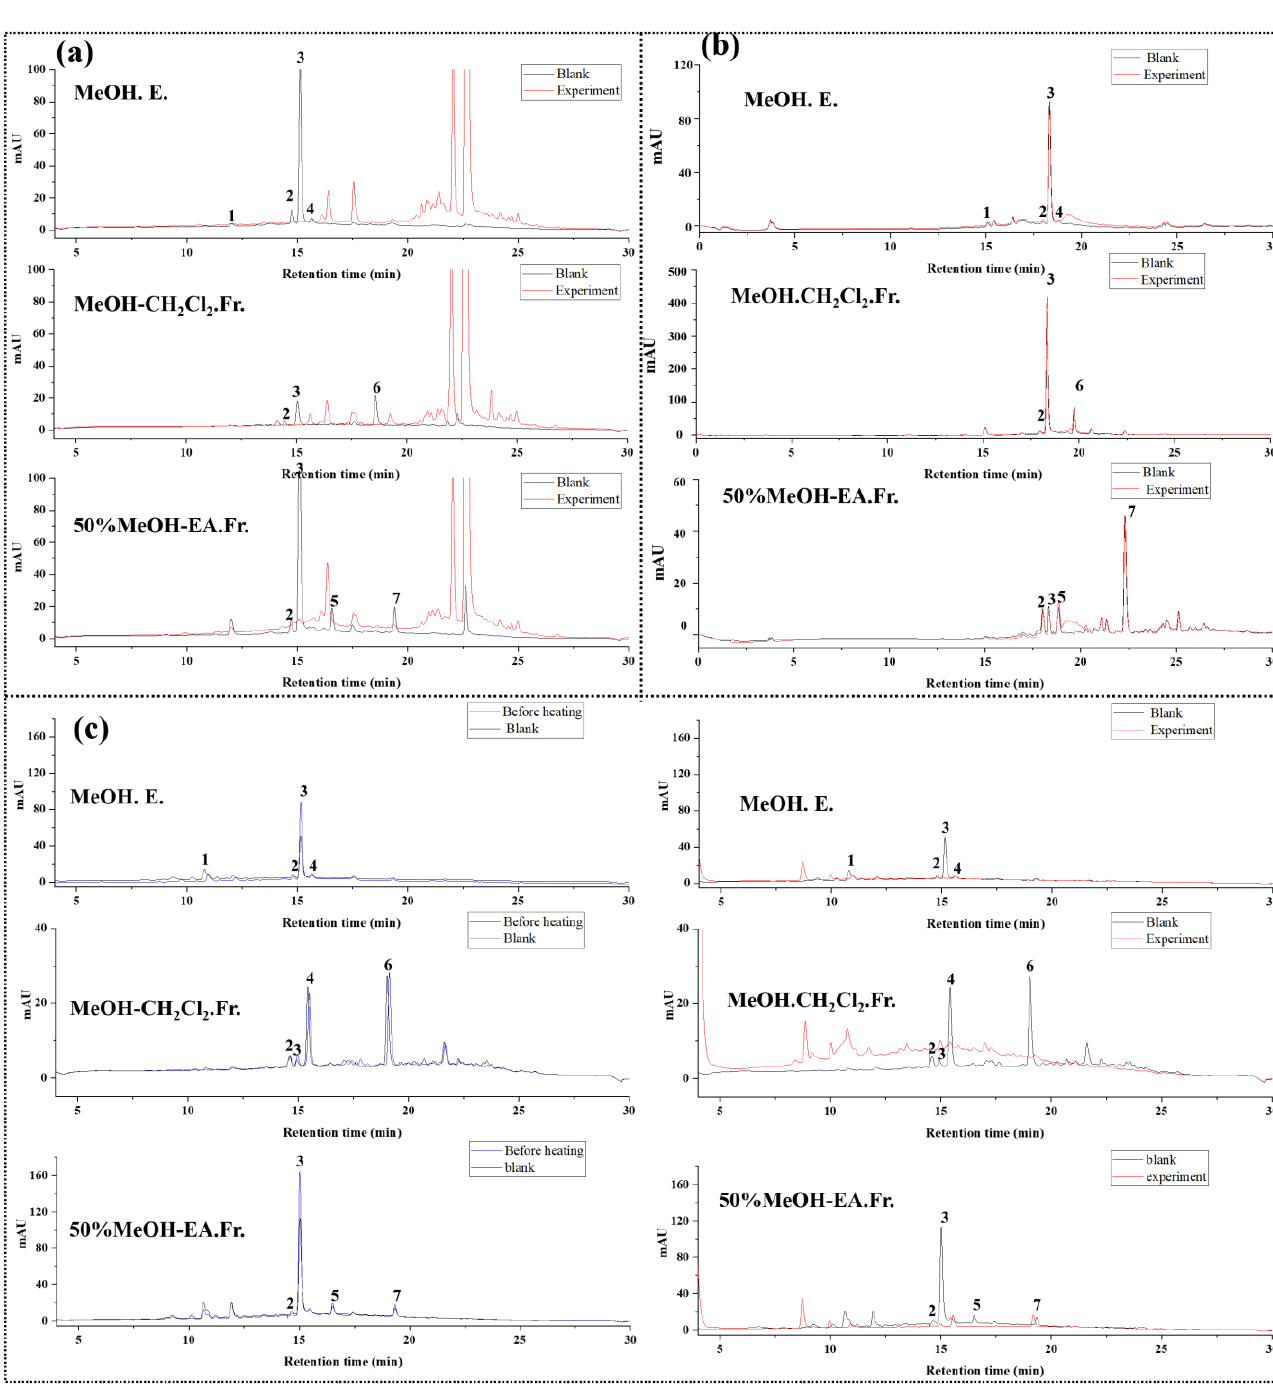
Figure 3. Results of screening antioxidants based on DPPH radicals ( a ), ABTS radicals ( b ), and AAPH radicals ( c ) from L. meyenii extracts and fractions.